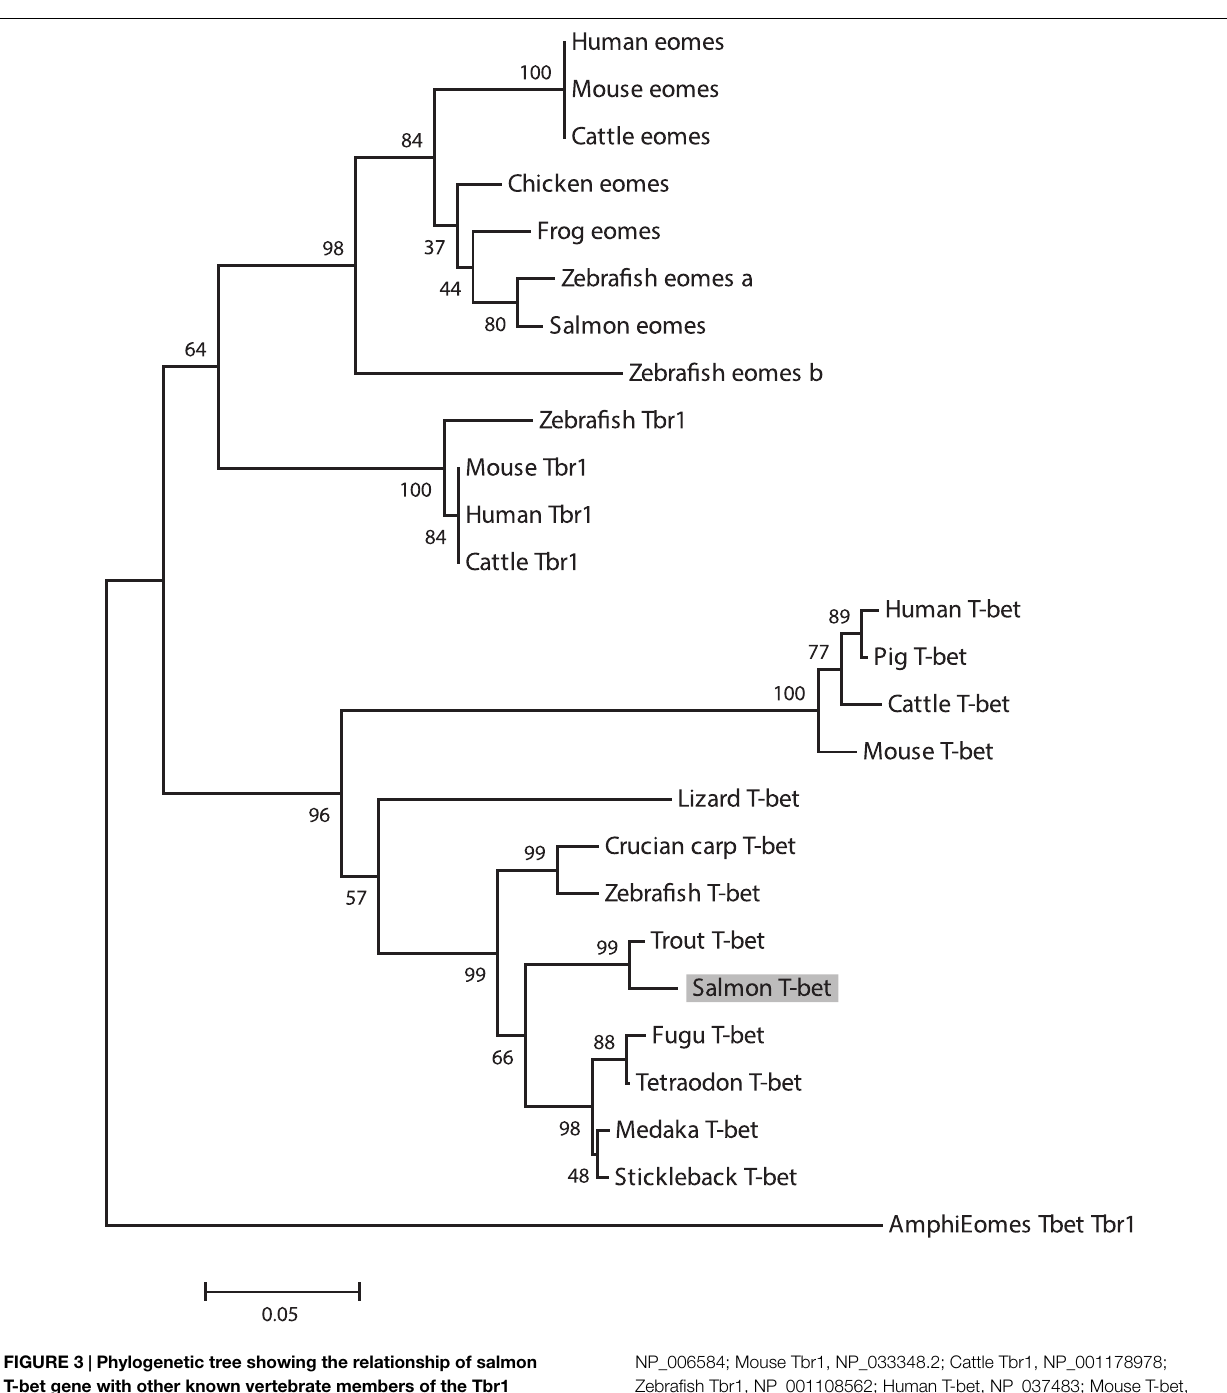
FIGURE 3 | Phylogenetic tree showing the relationship of salmon T-bet gene with other known vertebrate members of the Tbr1 subfamily . The phylogram was constructed on ClustalX2 and MEGA 4.1. The neighbor-joining (N-J) method with bootstrap values of 1000 replications was adopted. Accession numbers or ENSEMBL gene IDs are as follows: Human ( Homo sapiens ) Eomes, NP_005433; Mouse ( Mus musculus ) Eomes, NP_034266; Cattle ( Bos taurus ) Eomes, NP_001178117; Frog ( Xenopus laevis ) Eomes, NP_001081810; Chicken ( Gallus gallus ), Eomes, XP_426003; Zebrafish ( Danio rerio ) Eomes a, NP_571754; Zebrafish Eomes b, NP_001077044; Salmon ( Salmo salar ) Eomes, EU418014;